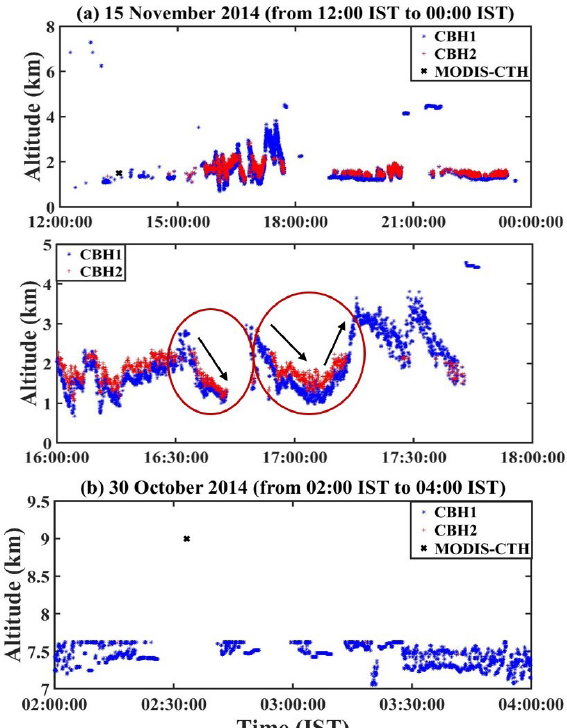
Figure 7. Comparison between cloud top height derived from MODIS, and CBH observed by the ceilometer during the monsoon season over the Ahmedabad region during sample days for (a) rain, and (b) no rain